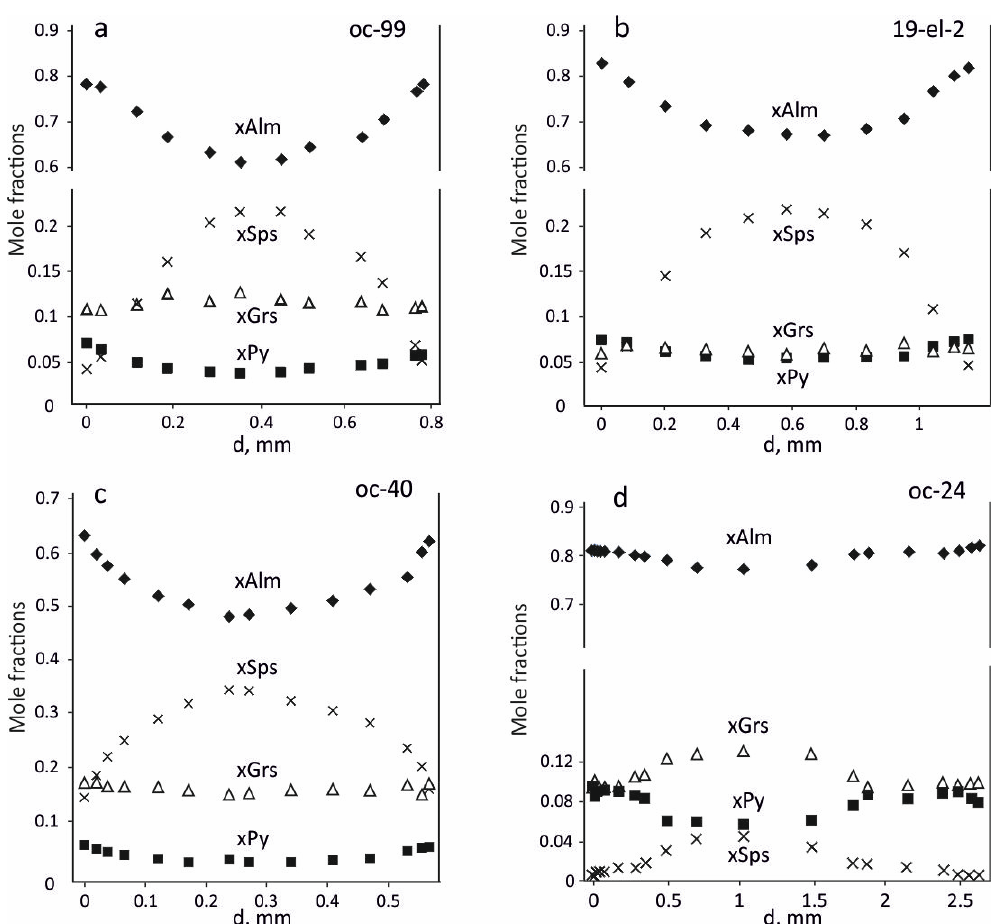
Figure 4. Compositional zoning profiles across garnet crystals of the garnet-biotite ( a – c ) and garnet-staurolite-chloritoid ( d ) schists.